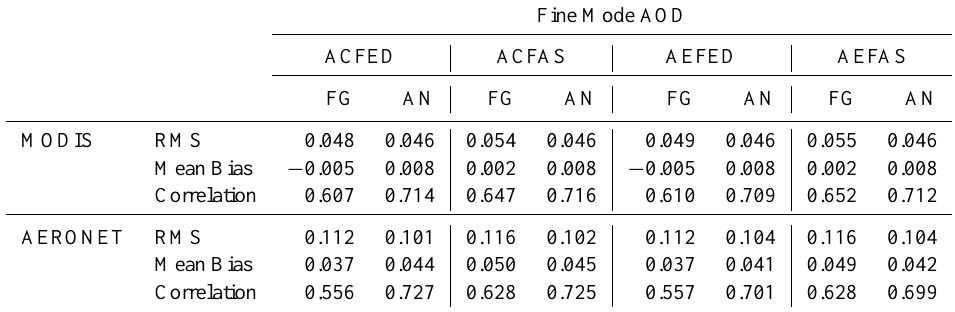
Table 2. Same as Table 1 but for fine mode